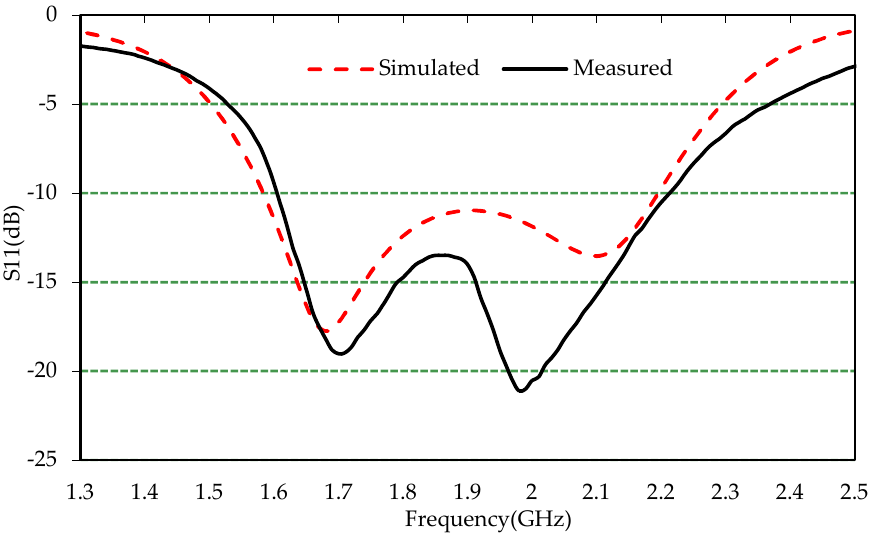
Figure 4. Simulated and measured S 11 .